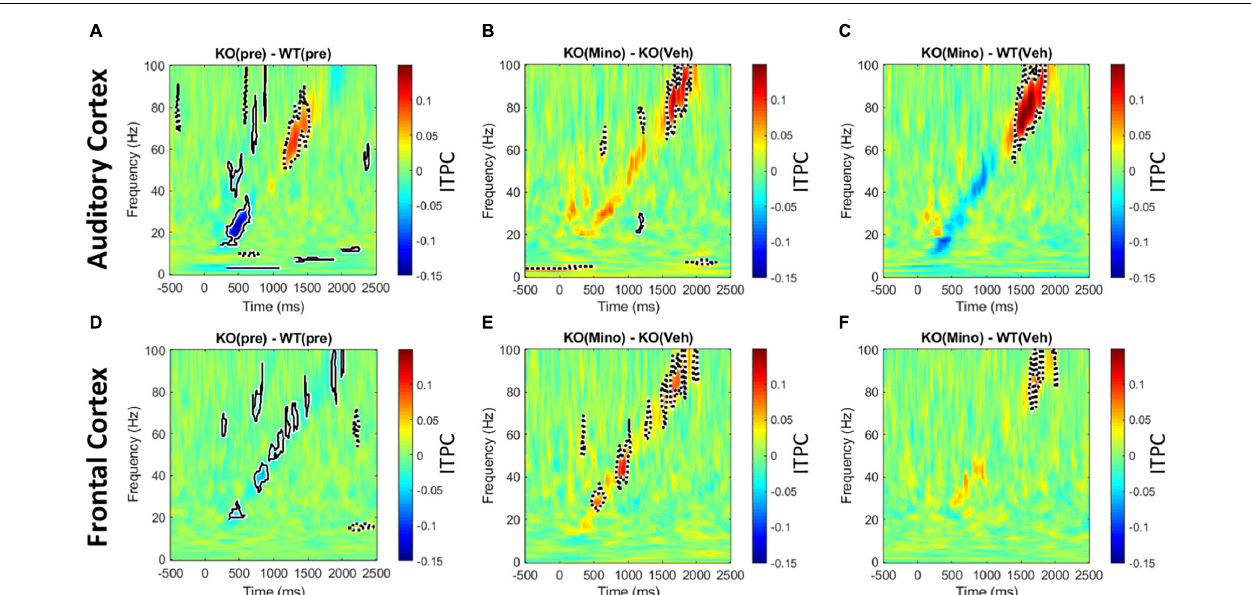
FIGURE 5 | Minocycline reverses phase locking deficits tested with chirp stimuli. (A–F) Colored regions are group mean differences between different genotype and drug conditions. Black-outlined regions are significantly reduced (blue with solid black outline) or increased (red with dotted black outline) as a result of a statistical permutation approach. (A, D) In the AC, there is a decrease in ITPC at beta to low-gamma bands, and an increase in ITPC in the high gamma range in the Fmr1 KO mice. In the FC, there is a decrease in ITPC between beta to high gamma frequencies. (B, E) Ten days of minocycline treatment increases ITPC in Fmr1 KO mice compared to vehicle in the FC, but not in the AC, suggesting a differential response of the two regions to this treatment. (C, F) The normalizing effect of minocycline in Fmr1 KO mice can be seen. In both the AC and FC, there is no difference between the minocycline treated KO and vehicle treated WT groups at beta/low-gamma